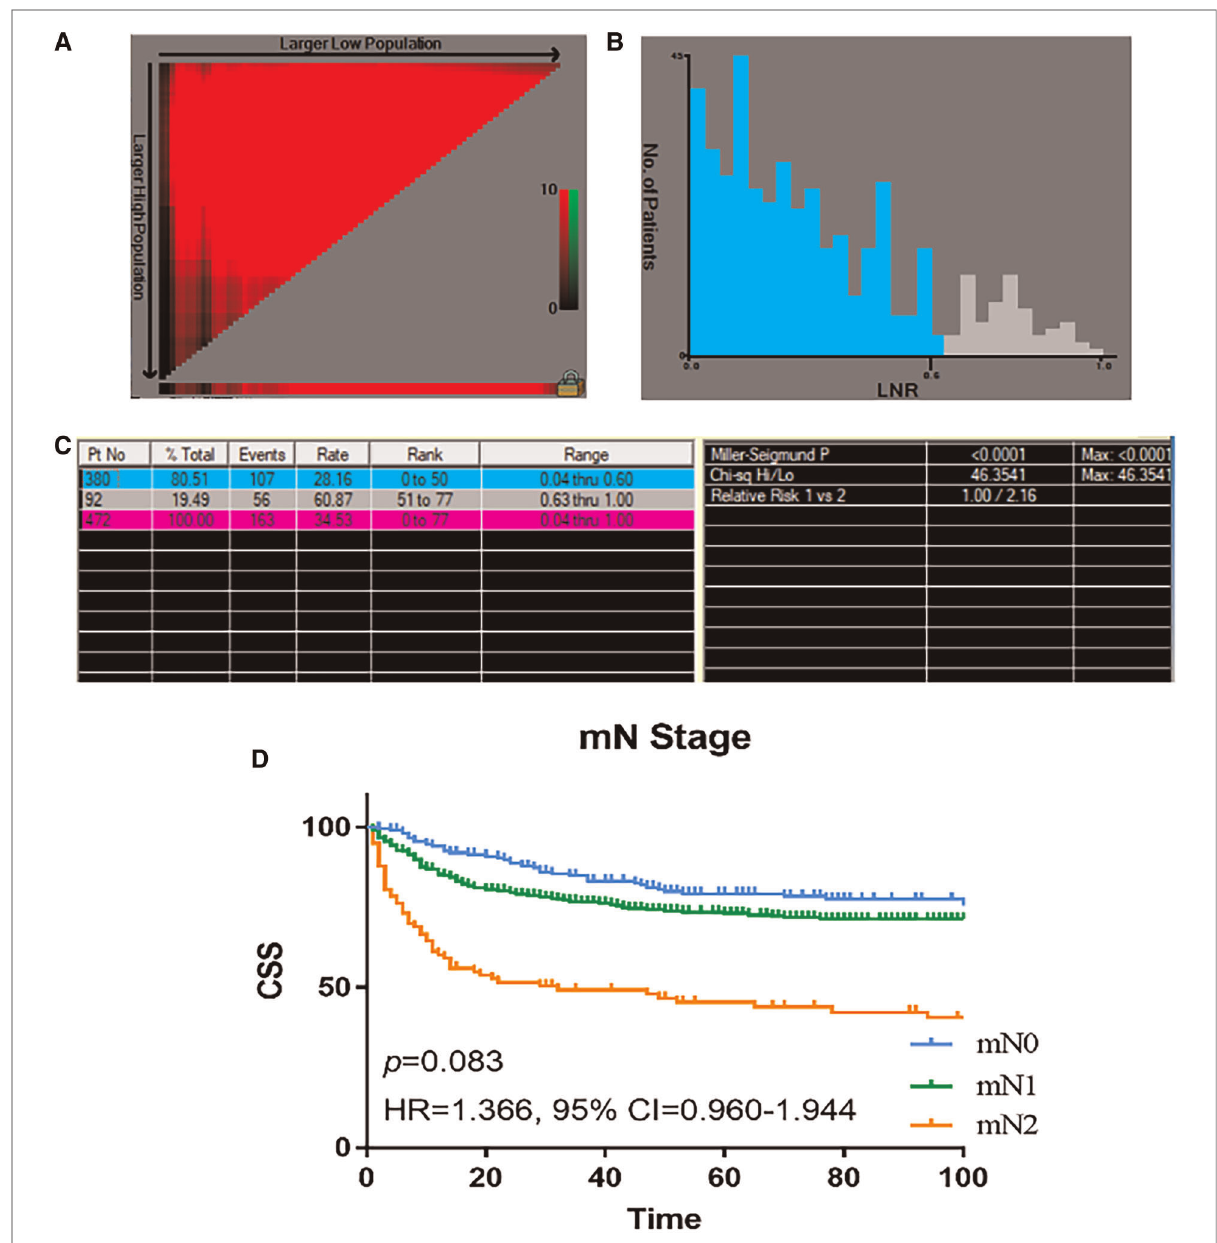
FIGURE 2 The optimal cut-off value of LNR in patients with colon NETs in the SEER registry was obtained by X-tile analysis. ( A , B ) The optimal cut-off value of LNR points of colon NETs patients. X-tile curve for number of LNR established by patients with colon NETs. ( C ) X-tile i mages of LNR and CSS after radical resection of colon NETs. ( D ) Analyses of the survival of mN staging. LNR, lymph node ratio; NETs, neuroendocrine tumors; SEER, Surveillance, Epidemiology, and End